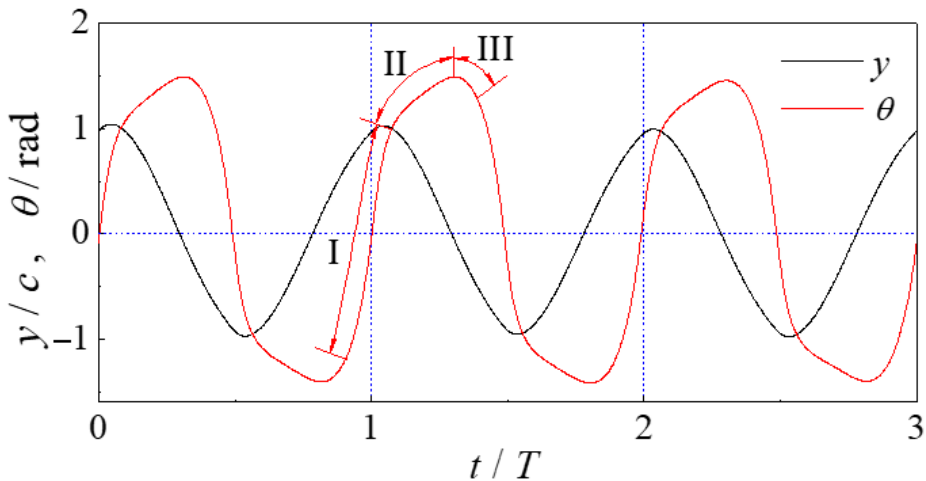
Figure 11. Time traces of the flapping motions with damping coefficient ζ = 0.177 in the baseline case. (The three phases represented by Roman numerals in the figure represent fast pitching regime (region I), slow pitching regime (region II), and transitional pitching regime (region III)).